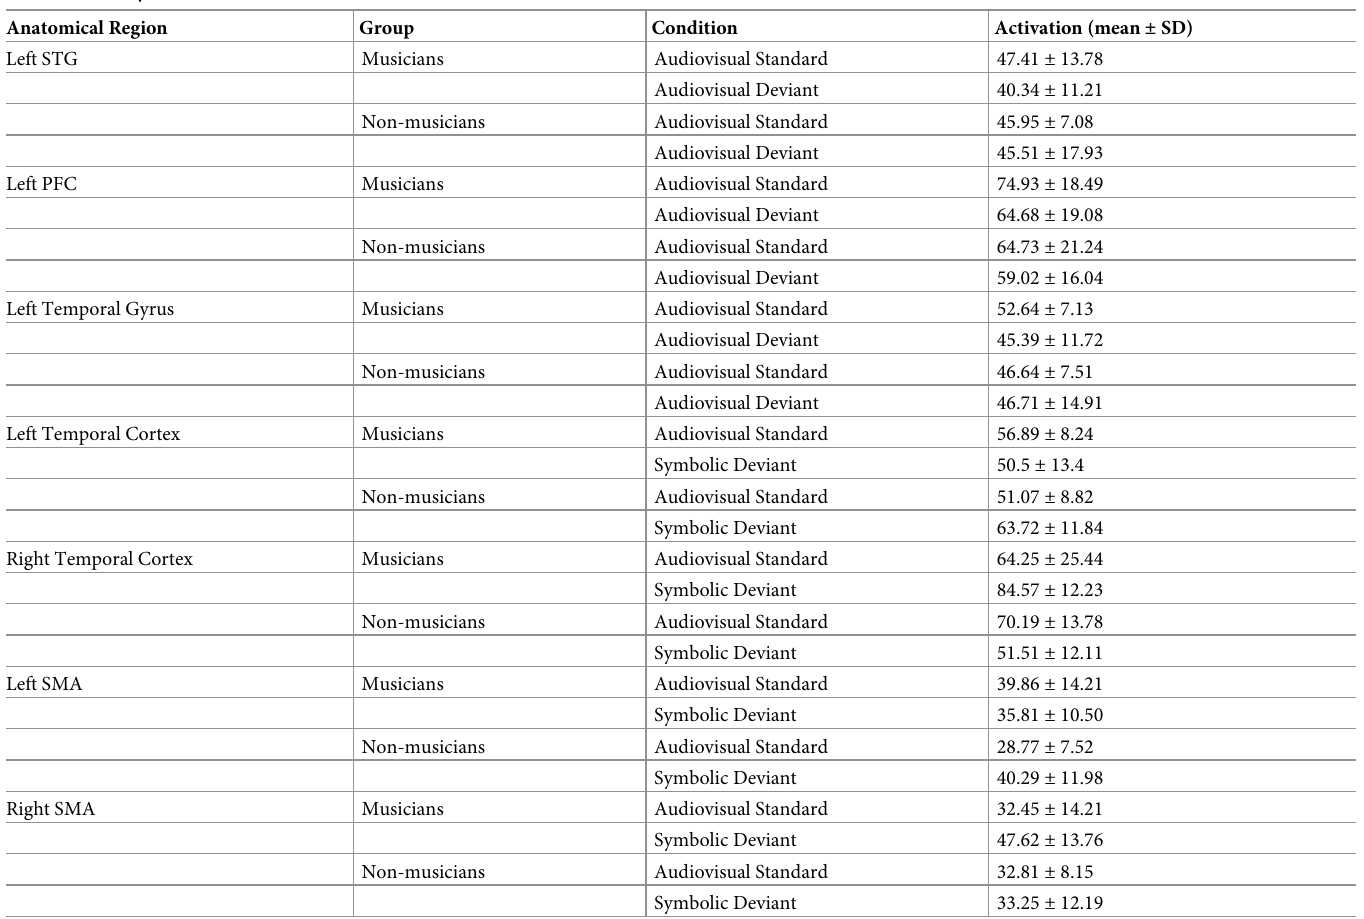
Table 1. Activity of each cluster for each contrast evaluated. Anatomical